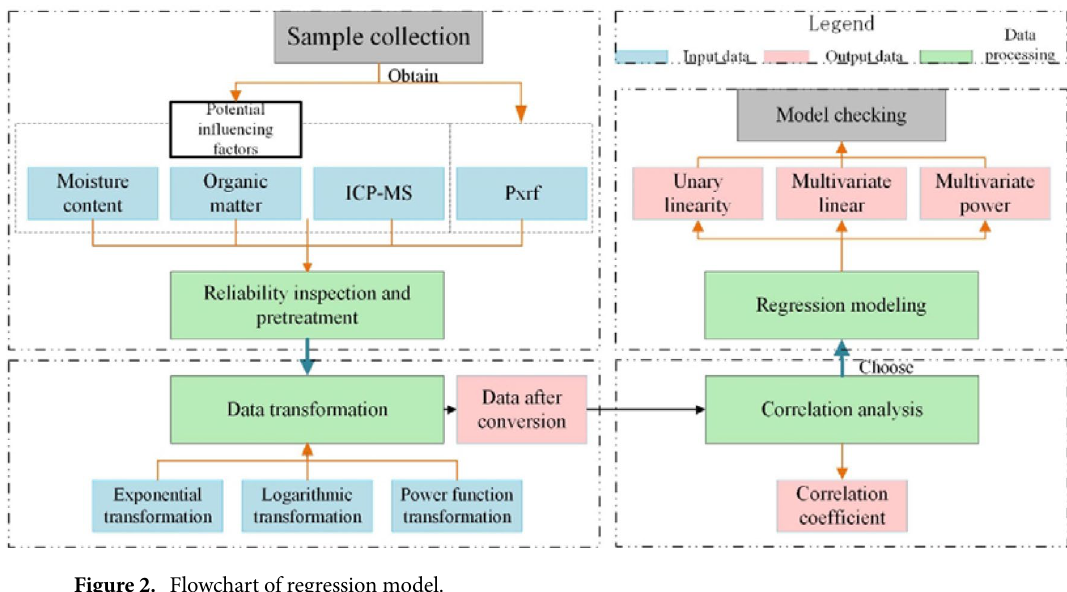
Figure 2. Flowchart of regression